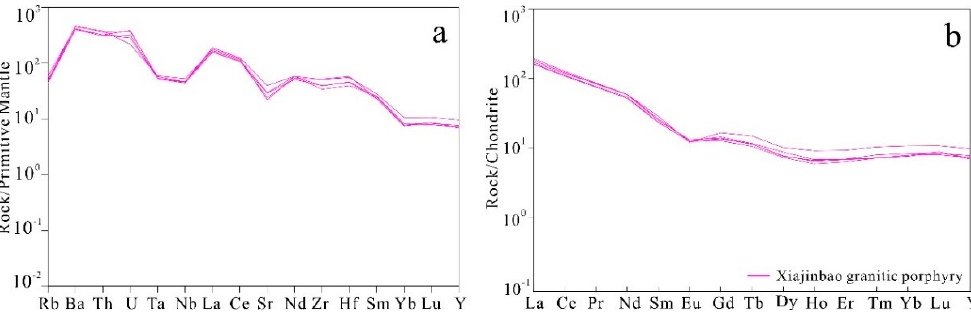
Figure 7. Primitive mantle-normalized trace element patterns ( a ) and Chondrite-normalized REE patterns ( b ) of the Xiajinbao granite.